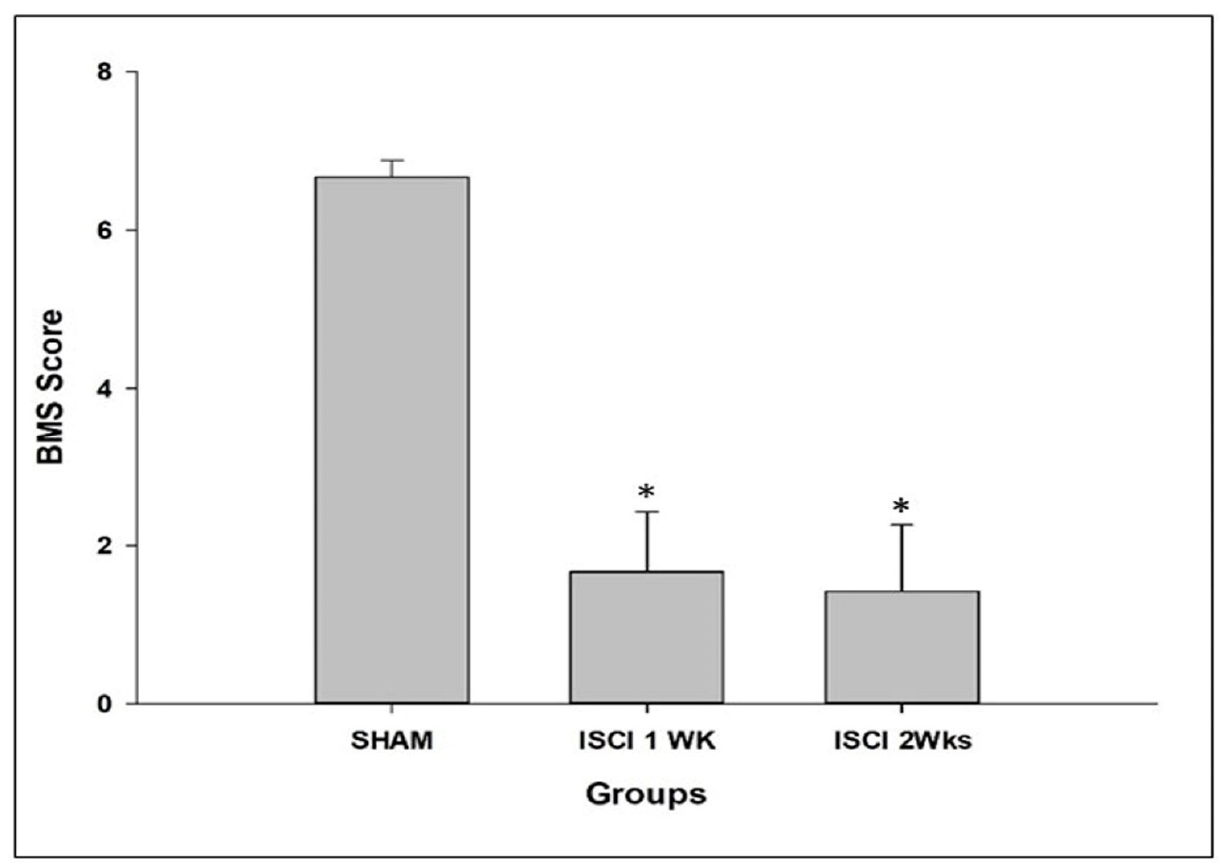
Figure 1. BMS score of the mice, post-surgery. Data are expressed as mean ± standard error. * p < 0.05 versus the sham group.